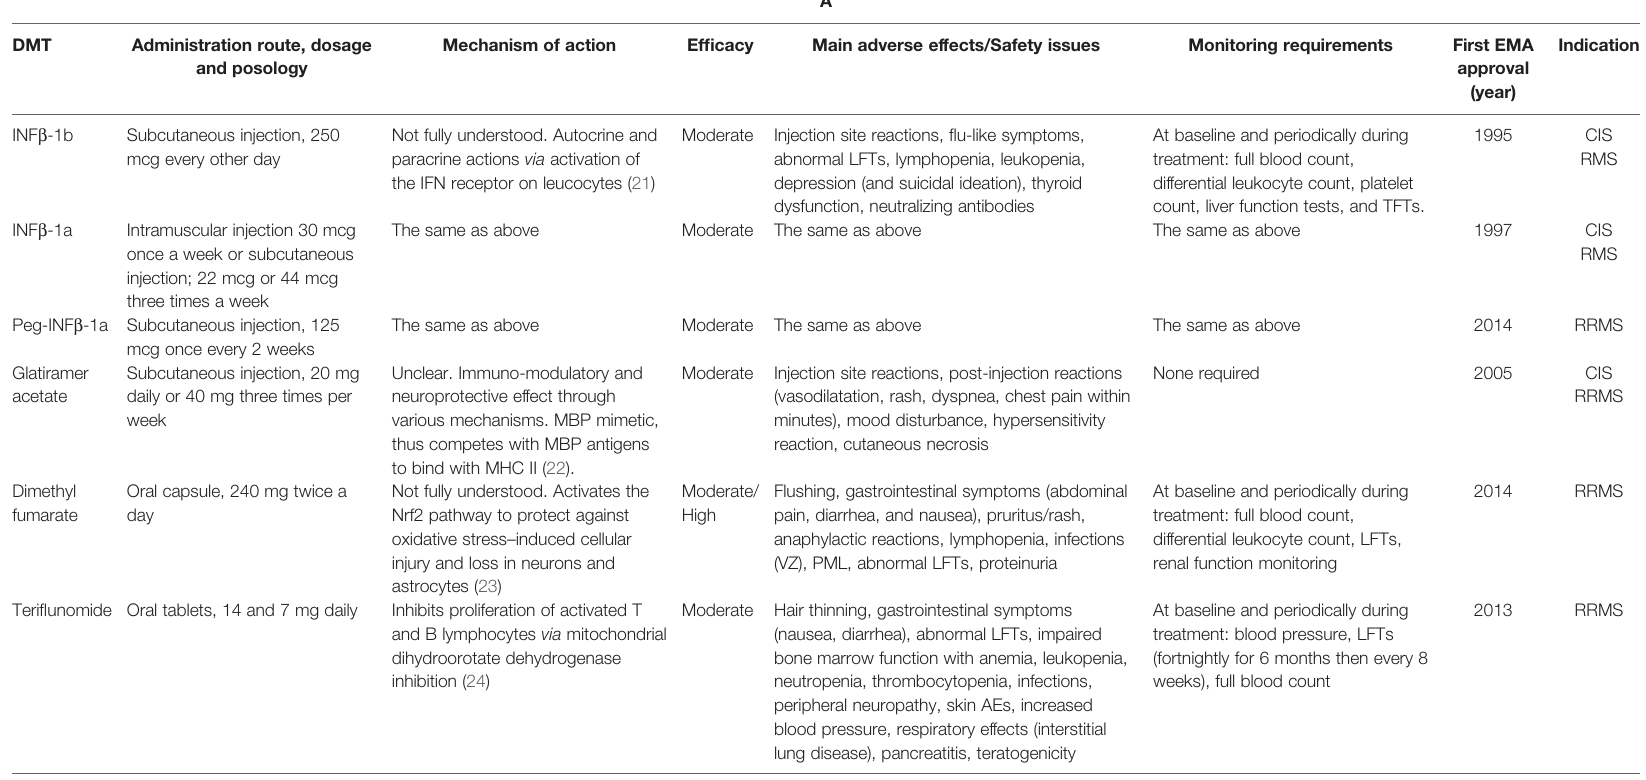
TABLE 1 | Disease-modifying therapies currently licensed for the treatment of MS; 1a) Common fi rst-line treatment; 1b) Common second-line